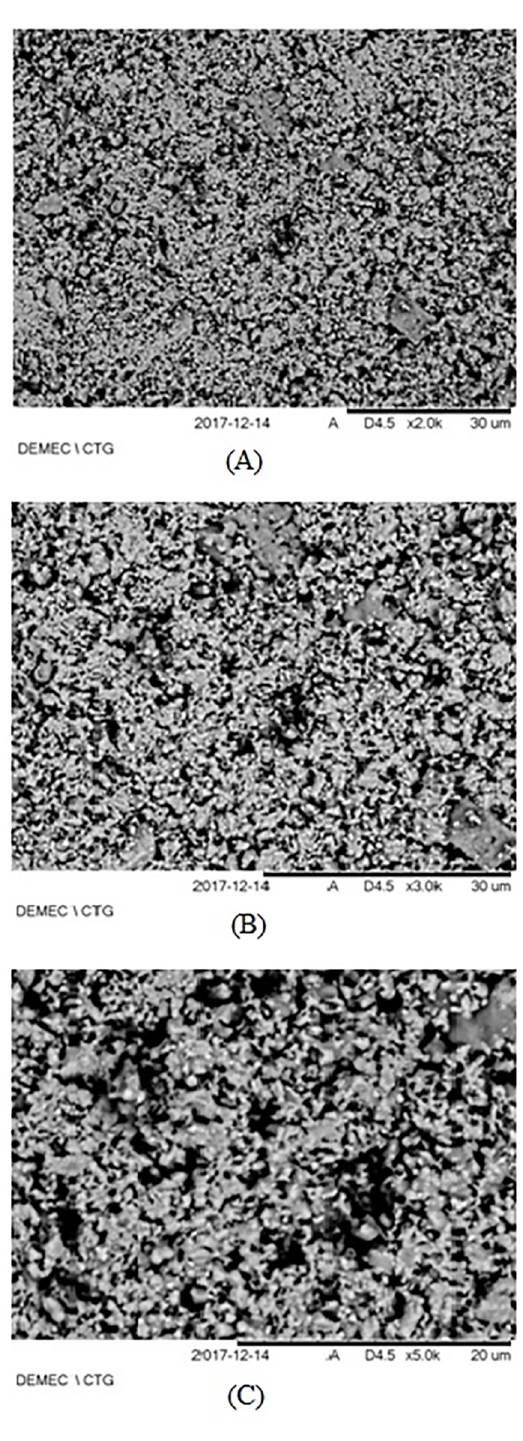
AlNbO ceramics sintered at 1150 2 6